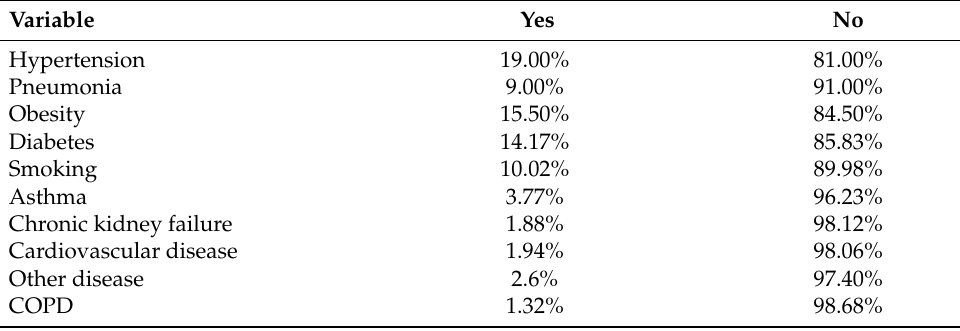
Table 2. Percentage of patients with any comorbidity, out of a total of 7,771,714